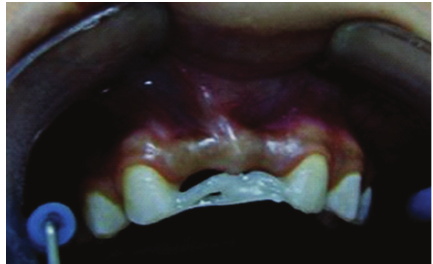
Figure 8: Appearance of fiber framework made two everStick C&B fiber bundles which covered large bonding areas on lateral incisors.